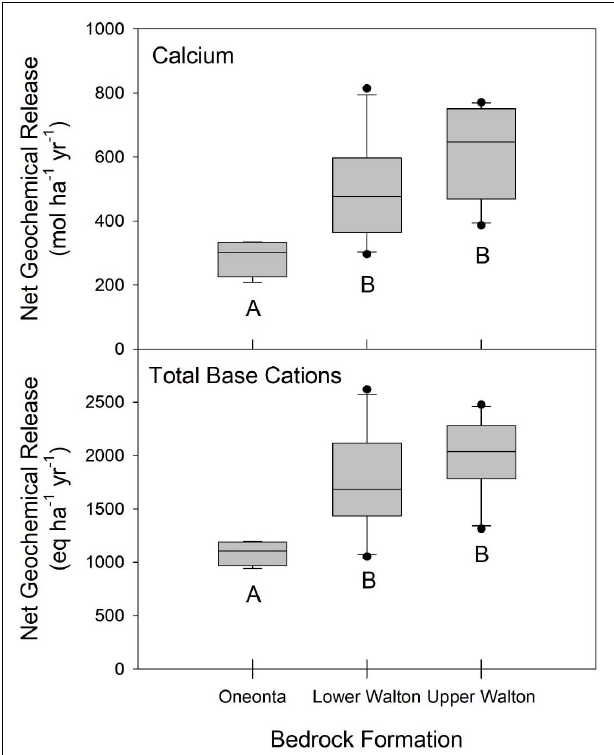
FIGURE 5 | Net geochemical release rates for the three dominant bedrock types. For the Oneonta, Lower Walton, and Upper Walton Formations, N = 4, N = 10, and N = 11, respectively. Median values are shown as a bold lines, the extent of the boxes are defined by the lower (25%) and upper (75%) quartiles. Individual values are plotted for samples that lie more than 1.5 times the interquartile range from the box. Differing letters indicate significantly different means, using one-way ANOVA ( P <